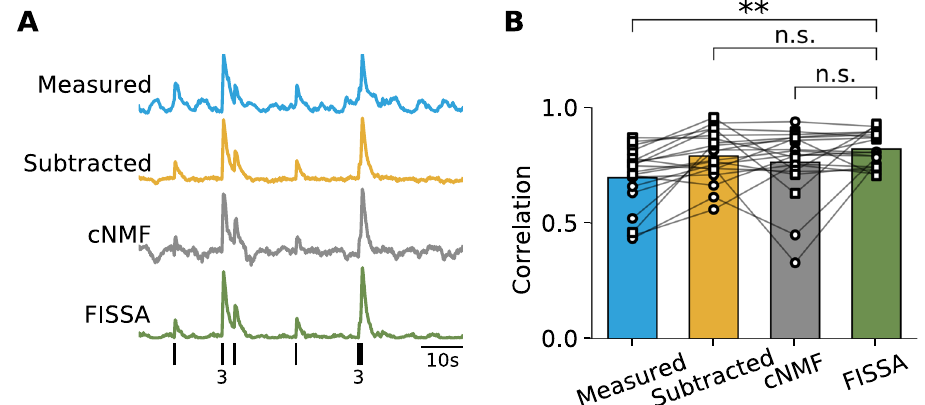
Figure 4. Comparison of neuropil decontamination methods on in vivo two-photon calcium imaging data from layer 2/3 neurons in mouse primary visual cortex (data from 3,24 ). ( A ) Example measured and decontaminated traces of fluorescence changes for cell 20120627_cell4 (frames 14400 to 19200). All traces were low-pass filtered at 5 Hz. The black ticks on the bottom row indicate the spikes measured electrophysiologically, with the number of overlapping spikes indicated below. ( B ) Correlations between the calcium transients inferred from the recorded spikes (see Methods), and the calcium signals estimated by each method. The data points correspond to GCaMP6s (circles) and GCaMP6f (squares) cells from the dataset 3,24 . ** p < 0.005; n.s.: not significant (p > 0.05); Wilcoxon signed-rank test, n = 20 cells, FISSA vs measured: p = 0.0006, FISSA vs subtraction p = 0.2959, FISSA vs cNMF p =